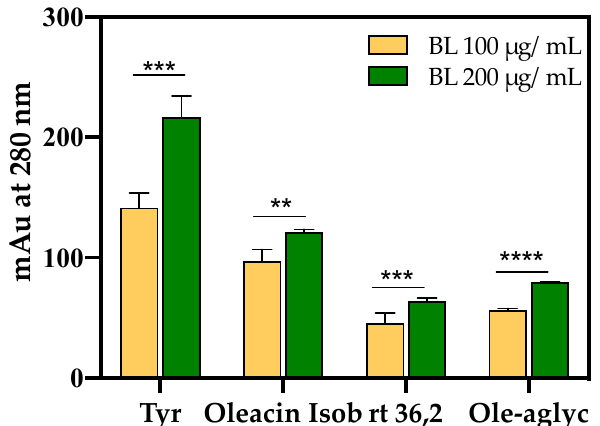
Figure 10. Main phenols in the BL samples were evaluated after incubation with the BUO extract at 100 and 200 µg/mL for 2 h, respectively. The data are the mean of triplicate experiments; the Ole aglycone isobar had rt 41.6 min, its oxidated derivative rt 36.2 and oleacin isobar rt 34.4 min (**, p < 0.01; ***, p < 0.001; ****, p < 0.0001). Bars were analyzed by Two-Way ANOVA followed by Tukey's test.